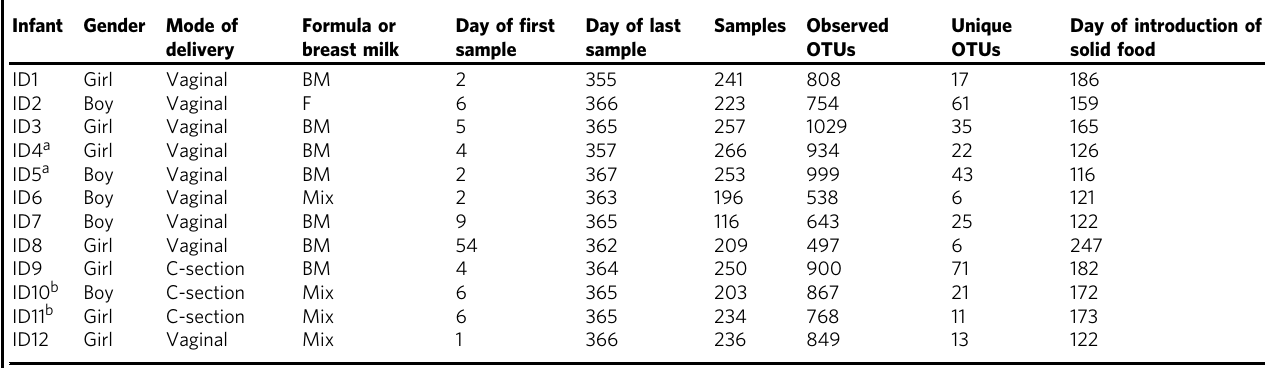
BM = breastmilk, F = formulafed,Mix = bothbreastmilkand formula.ThenumerofOTUsobservedarethetotal numberofOTUsobservedinaninfantovertheentiresamplingperiod.Thenumberof unique OTUs are the number of OTUs found only in that infant a ID4 and ID5 are siblings born ~16 months apart b ID10 and ID11 are fraternal